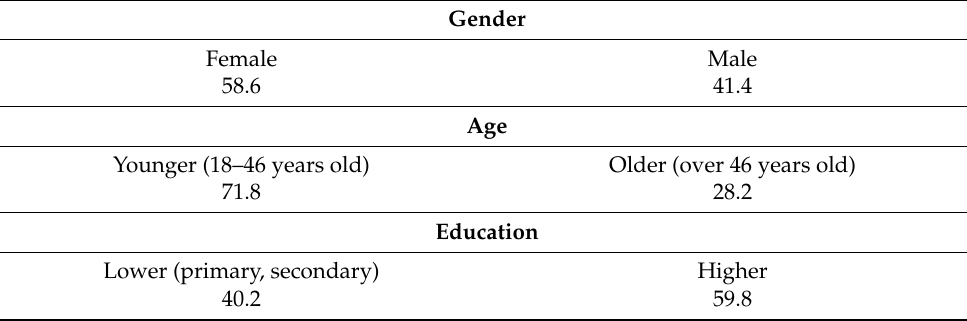
Table 1. Characteristics of the study population ( n = 434, data in